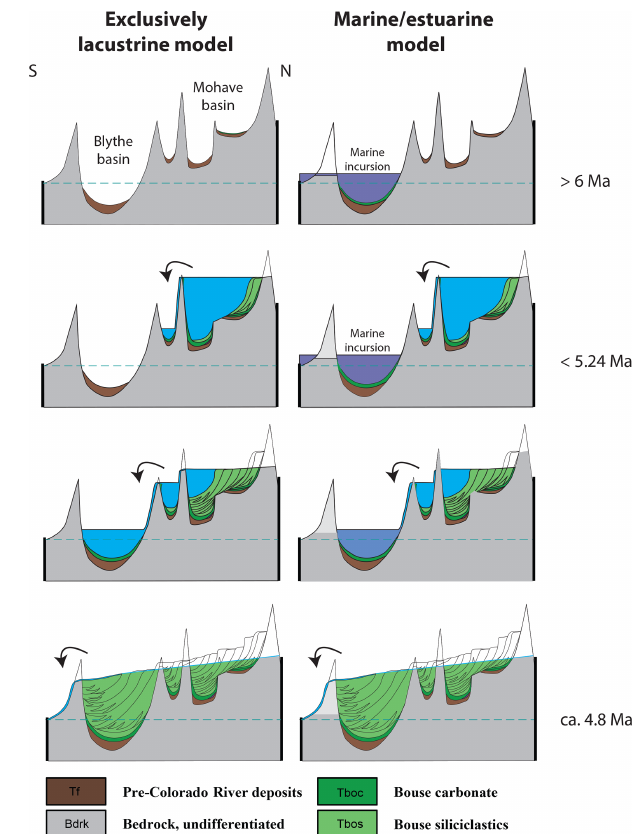
Figure 3. Alternative paleoenvironmental models for the Bouse Formation (after Pearthree and House, 2014). In the exclusively lacustrine model (Spencer and Patchett, 1997; House et al., 2008; Roskowski et al., 2010; Spencer et al., 2013; Bright et al., 2016, 2018a, b) the precursor internally drained Miocene basins and fan- glomerate and playa deposits (brown) of the future lower Colorado River valley were successively flooded by a series of overspilling lakes, initially depositing the transgressive tufa, marl, and shelly carbonates of the lower Bouse Formation (dark green). Upstream basins were rapidly infilled by the progradational sediment bodies of the early Pliocene, upper siliciclastic Bouse (light green) (and later, Bullhead Alluvium), which eventually integrated the evolv- ing Colorado River system into the proto-Gulf of California in the early Pliocene. Subsequent downcutting of the system resulted in the graded deposystem that has evolved since the early Pliocene. In the marine/estuarine model (Buising, 1990; McDougall and Mi- randa Martínez, 2014; Dorsey et al., 2018), arrival of the prograd- ing Colorado River system into the Blythe basin was preceded in the late Miocene by a marine incursion, resulting in the forma- tion of marine or estuarine bioclastic carbonates of the lower Bouse through one or more transgressive events. Subsequent arrival of the prograding and then downcutting Colorado River system then trans- formed the deposystem in a manner similar to the lacustrine